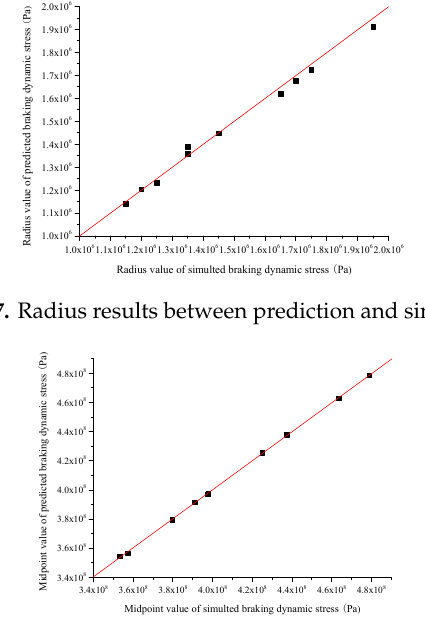
Figure 18. Midpoint results between prediction and simulation.